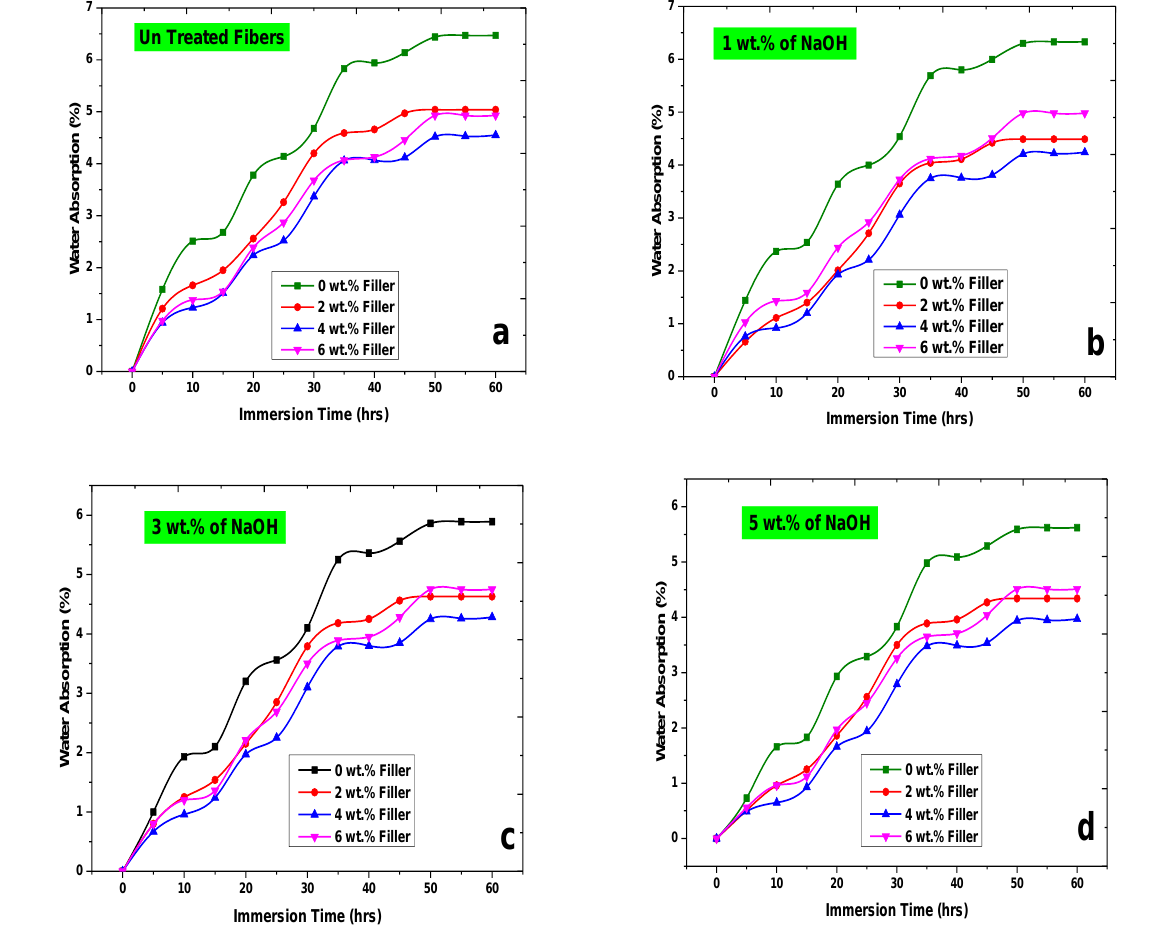
Figure 15. Moisture Absorption Behaviours of ( a ) Untreated; ( b ) 1 wt.% of NaOH; ( c ) 3 wt.% of NaOH; ( d ) 5 wt.% NaOH treated sisal/flax/Nano Al 2 O 3 /Epoxy based hybrid composites.